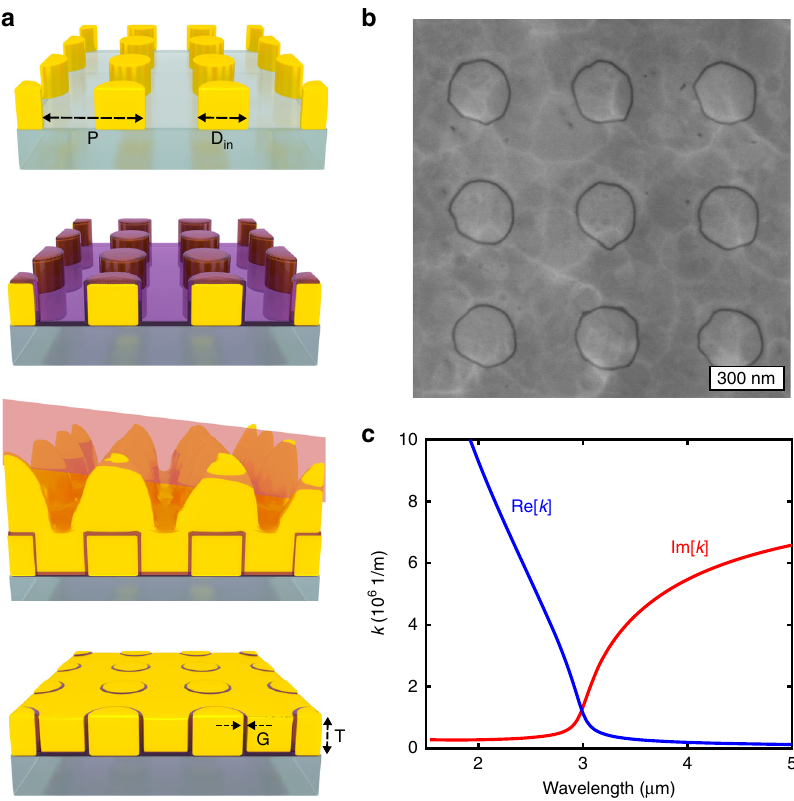
Fig. 1 Schematics of the coaxial nanoapertures and its epsilon-near-zero (ENZ) optical property. a The illustration of coaxial nanoapertures shows geometrical parameters including an inner diameter ( D in ), gap size ( G ), period ( P ), and thickness of the gold fi lm ( T ). Processing scheme: (1) Gold nanopillars are patterned via electron-beam lithography; (2) ALD coating of gap- fi lling insulators (Al 2 O 3 ; thickness from 1 to 10 nm); (3) gold sputtering; (4) glancing-angle ion milling to planarize the top surface and expose the Al 2 O 3 - fi lled nanocoax array. b Scanning electron microscopy (SEM) images of coaxial nanoapertures with a 10 nm alumina gap, 250 nm diameter, 500 nm period, and 150 nm Au thickness. c Dispersion of a guided mode (real and imaginary parts) of a coaxial waveguide (250 nm diameter and 10 nm gap width) in a gold fi lm illuminated with a linearly polarized beam at